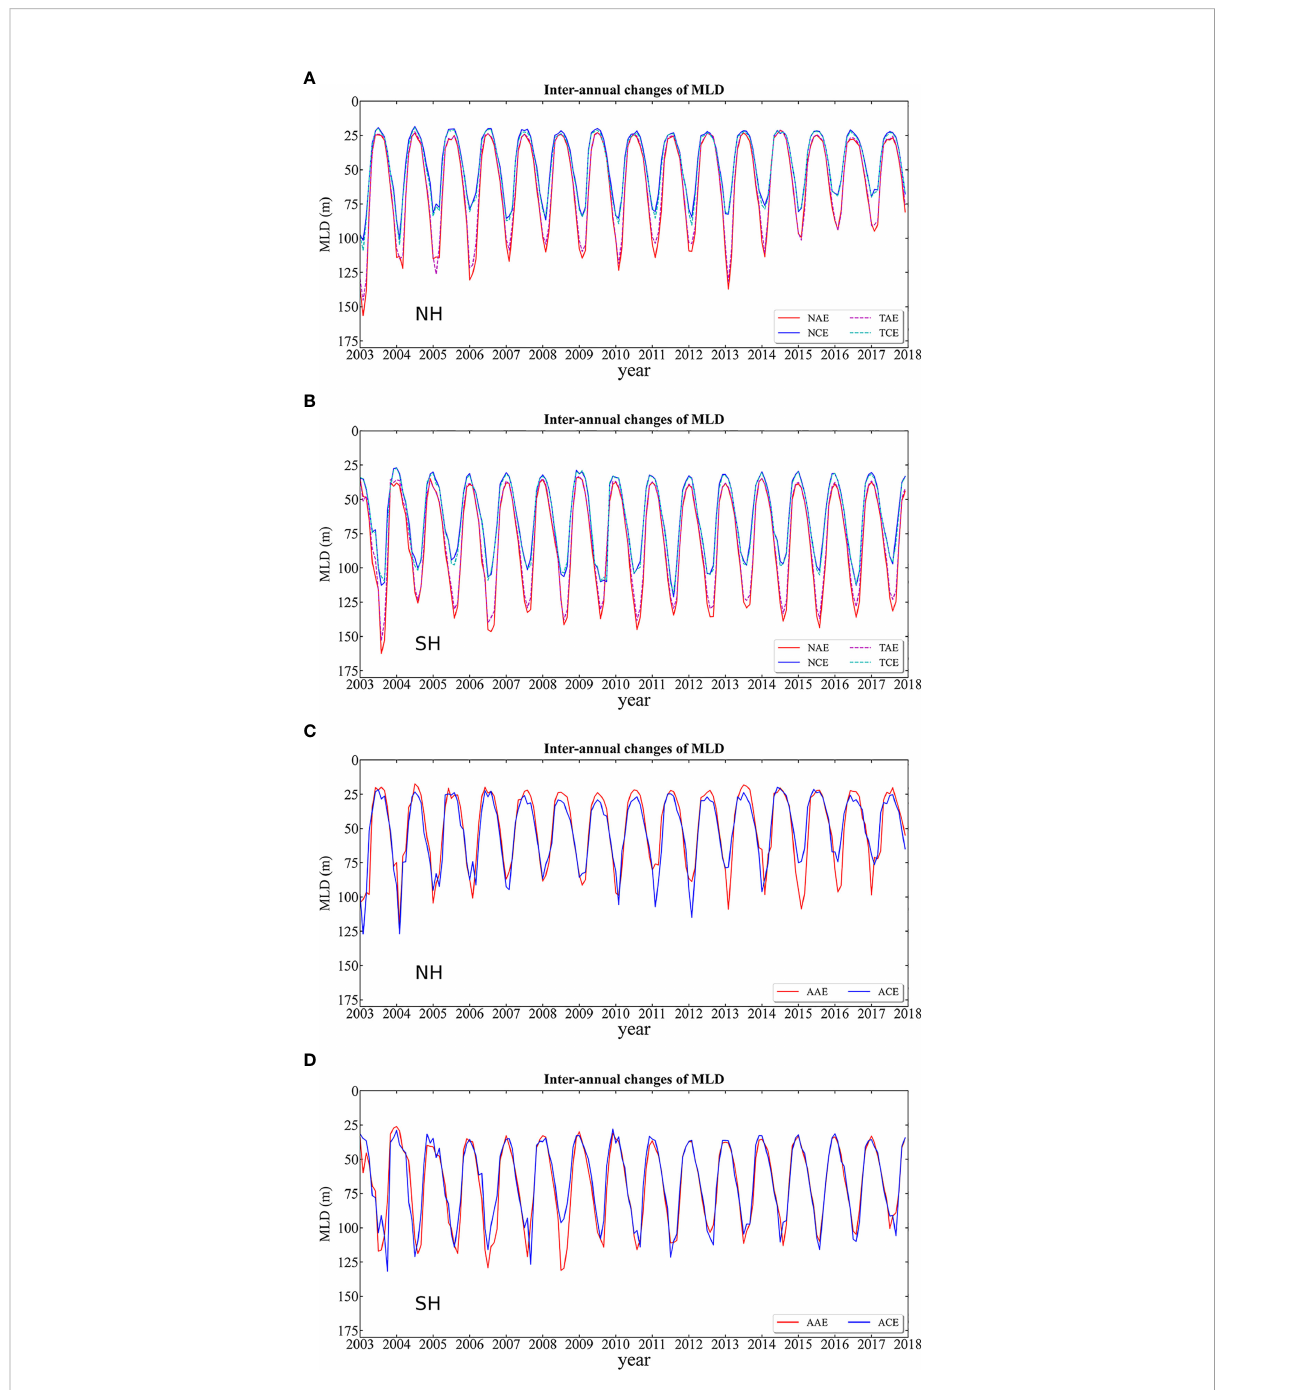
FIGURE 9 Inter-annual variability of eddies-induced MLD in NH (northern hemisphere) and SH (southern hemisphere). The solid (dashed) red (magenta) line and solid (dashed) blue (cyan) line represent NAE (TAE) and NCE (TCE) in (A, B) The solid red (blue) line in (C, D) indicates AAE (ACE),